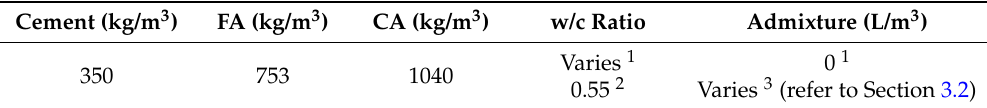
Table 3. Concrete mixture composition.